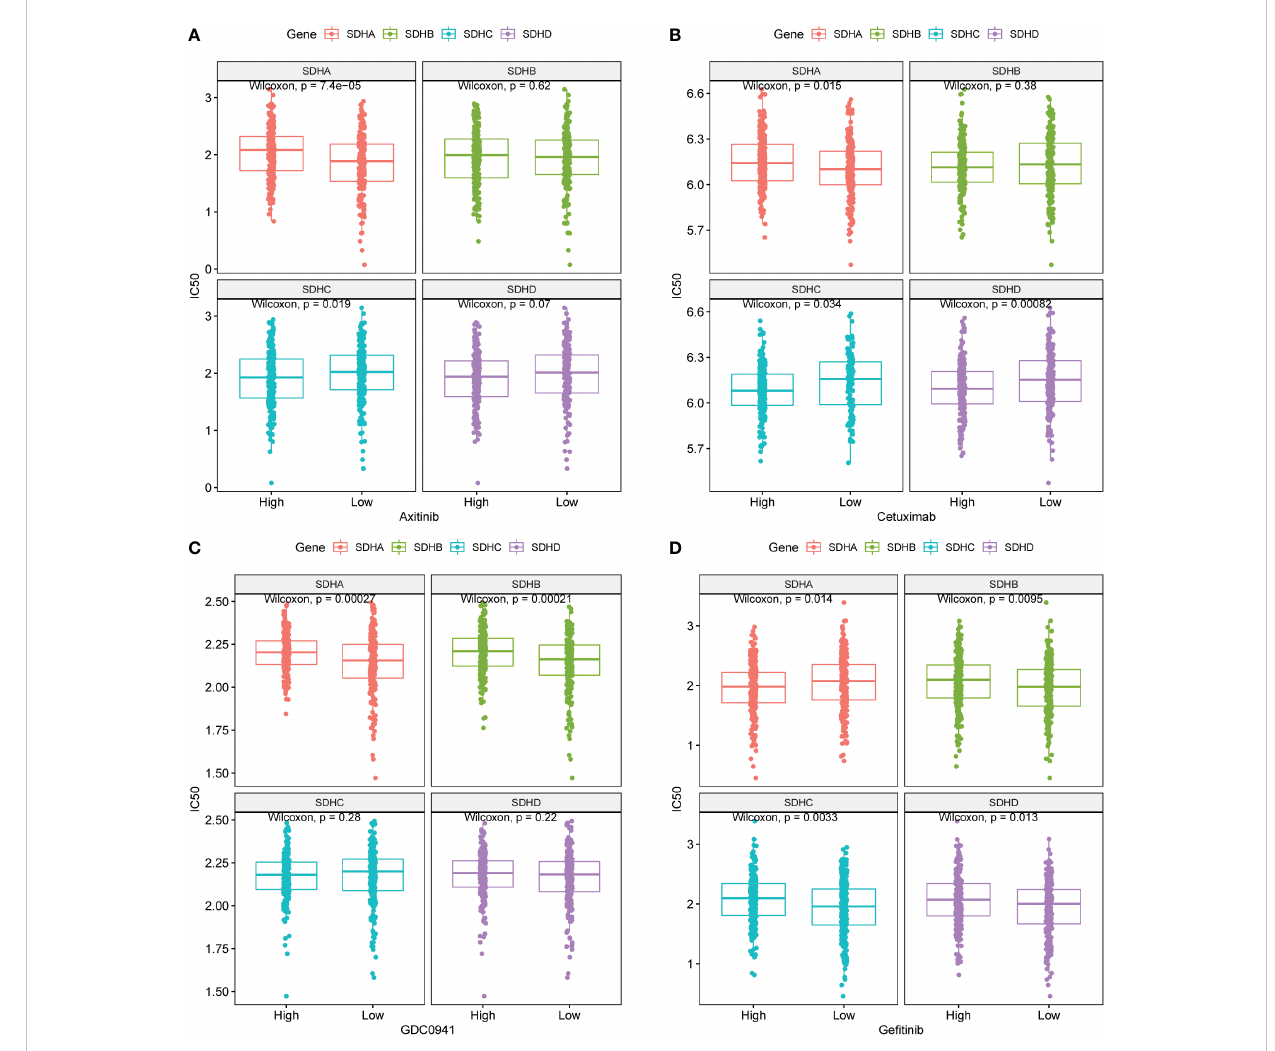
FIGURE 8 Targeted drug therapy outcomes prediction. (A-D) GDSC predicts the IC50 difference of four drugs between COAD patients with different SDHs